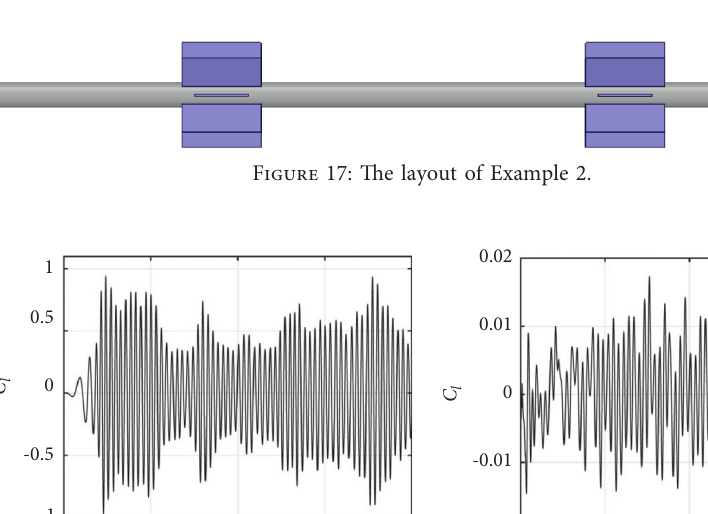
Figure 16: Comparison of lift coefficient and PSD with and without spoilers for Example 1. (a) Time history of lift coefficient (bare). (b) Time history of lift coefficient (with spoilers). (c) PSD of the lift coefficient (bare). (d) PSD of the lift coefficient (with spoilers).